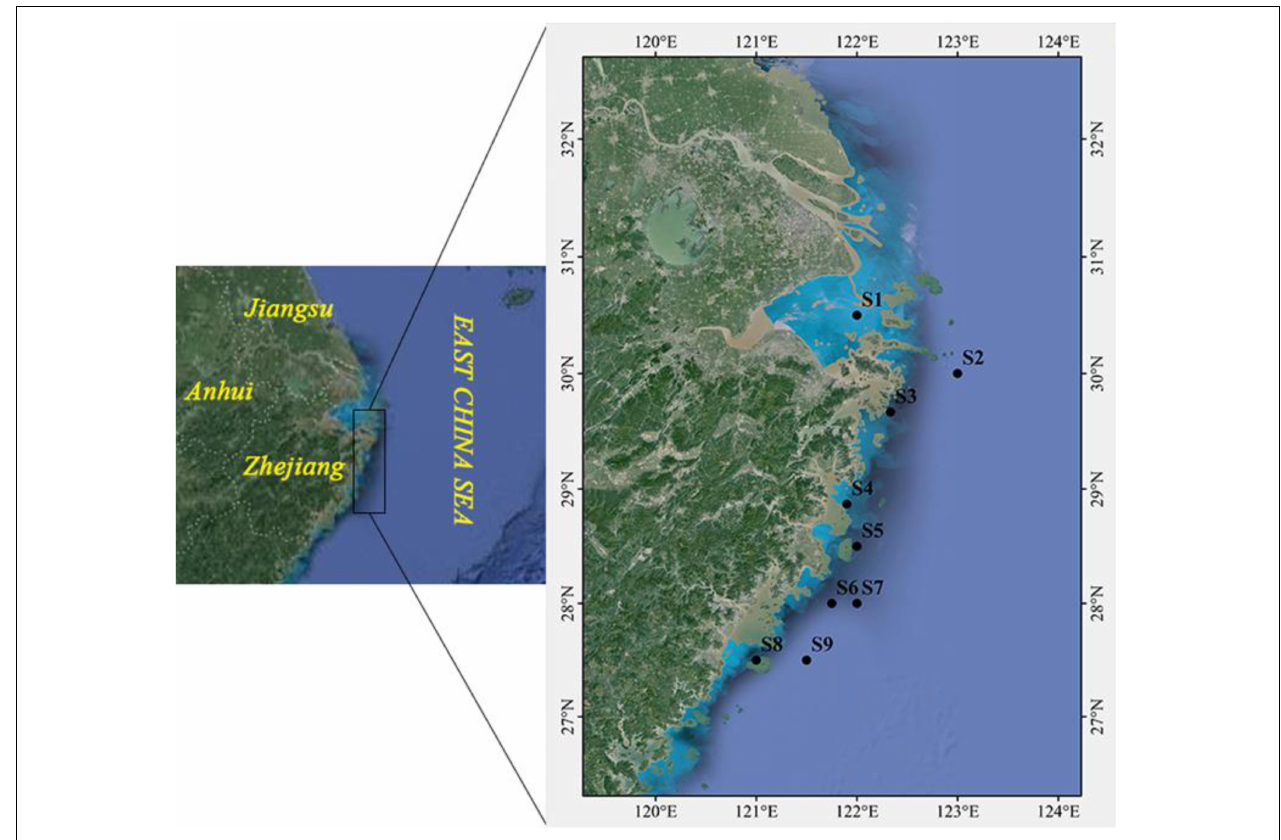
FIGURE 1 | Descriptive map of the sampling